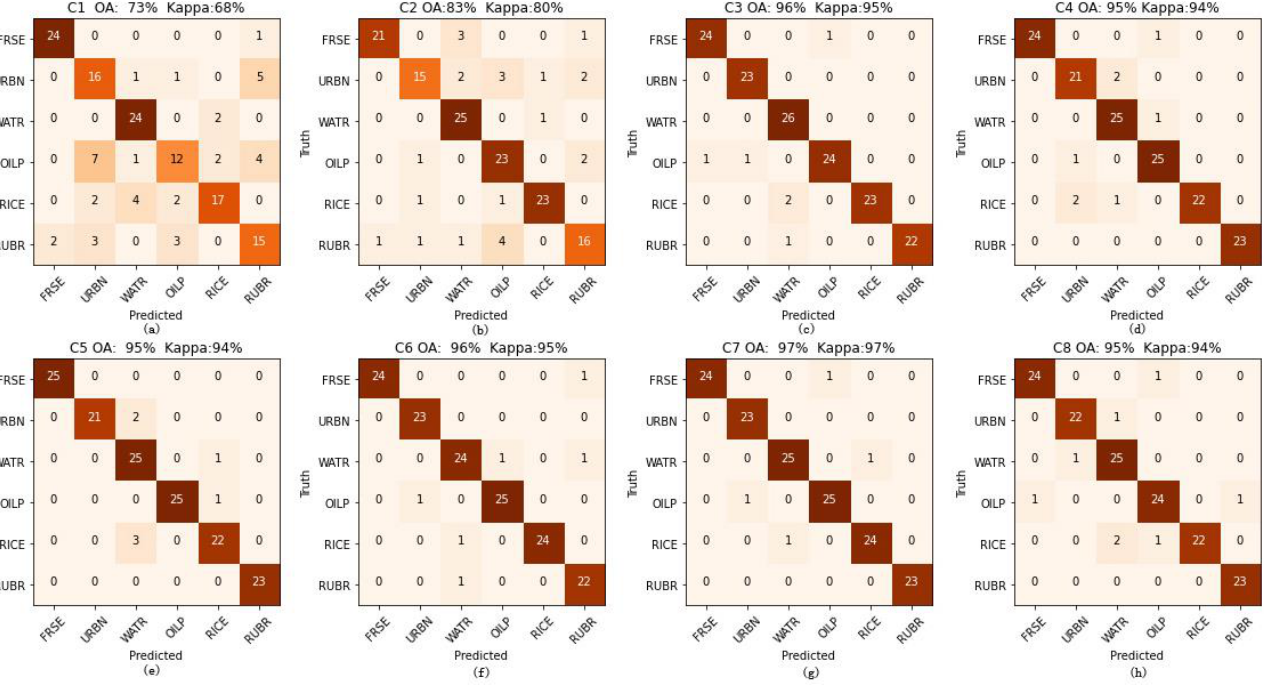
Figure 5. Confusion matrix plot for ( a ) C1 — PALSAR2, ( b ) C2 — Sentinel-1, ( c ) C3 — Sentinel-2A, ( d ) C4 — Landsat 8, ( e ) C5 — Landsat 8 + PALSAR2, ( f ) C6 — PALSAR-2 +Sentinel-2, ( g ) C7 — Sentinel-1 +Sentinel-2 and ( h ) C8 — Sentinel-1 + Landsat 8 combinations.